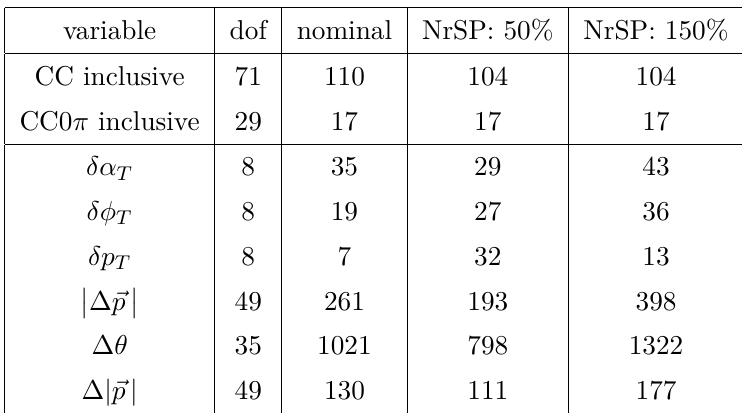
Table 3 . χ 2 -likelihood test for T2K variables. The number of degrees of freedom (dof) is given in the second column, while in the another three ones, results obtained for different distributions and three NrSP — proton re-scattering probability — configurations (nominal, 50% and 150% strengths) are